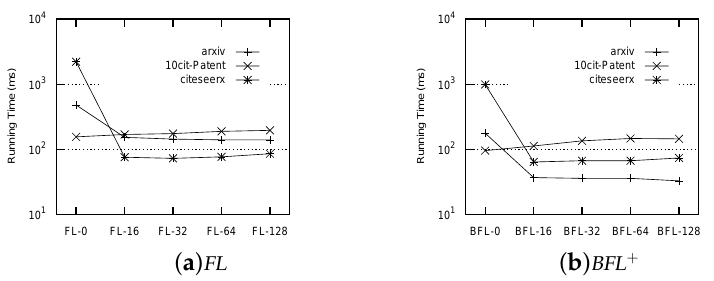
Figure 7. Impacts of k on query time (ms) over different